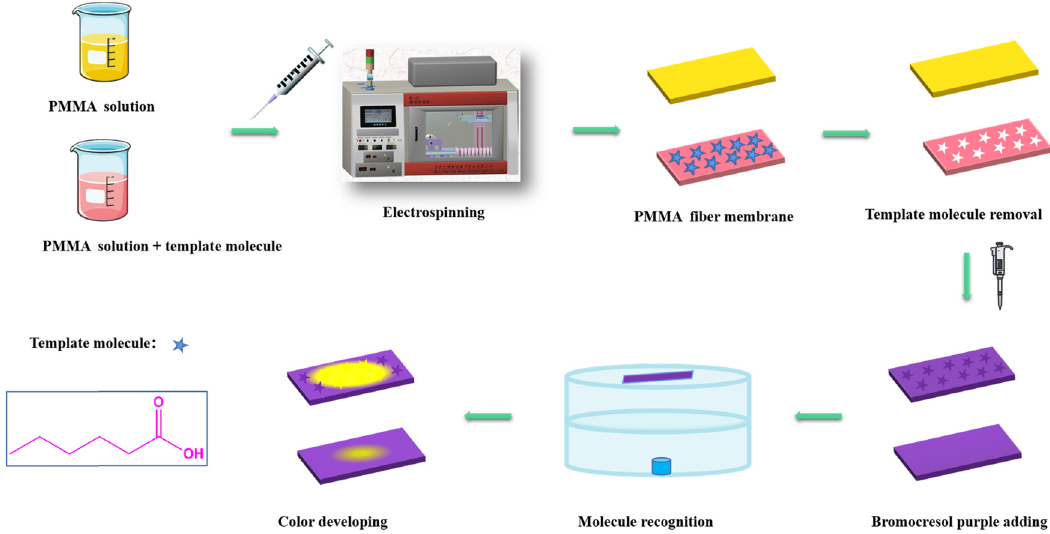
Figure 1: The schematic of the experimental process about MIM - BCP and NIM -